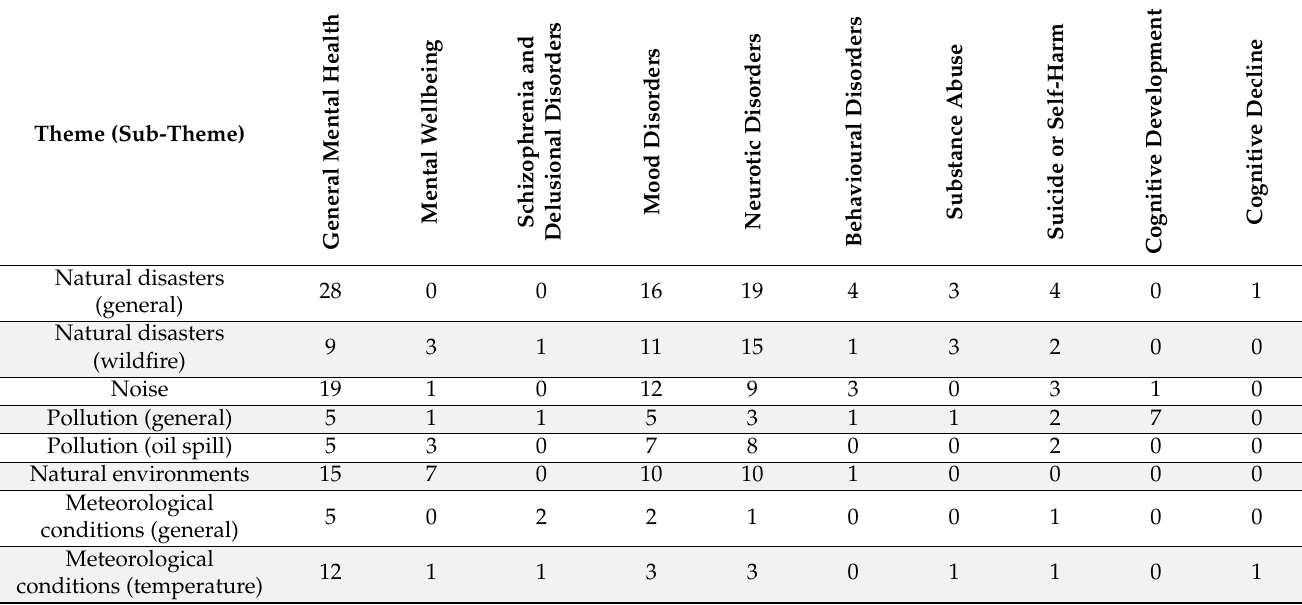
Table 5. Number of papers identified through scoping review by environmental science theme and mental health